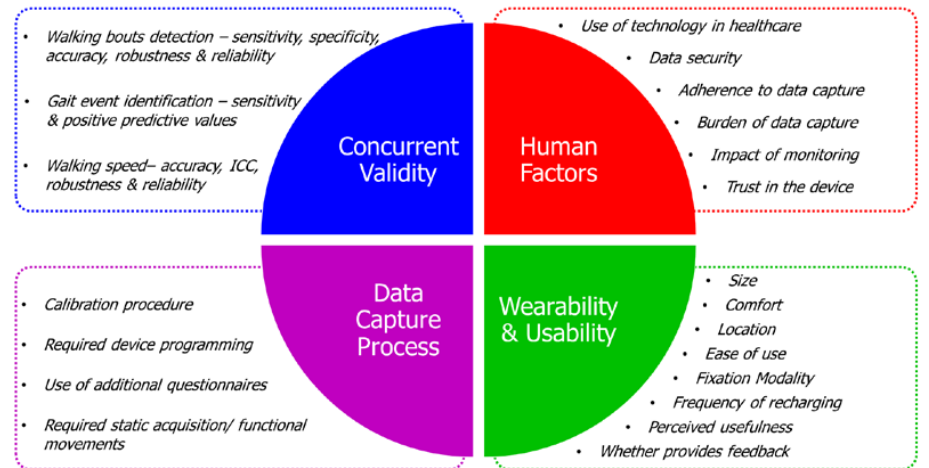
Figure 2. Identified key domains and their relevant criteria affecting wearable devices selection.